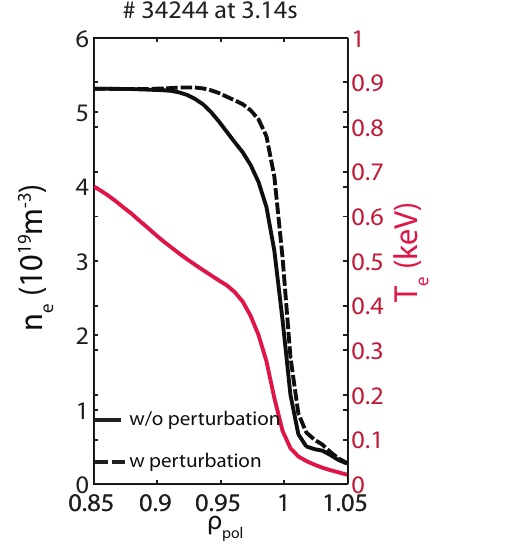
Figure 3. #34244 at 3.14 s: Input profiles of T e (red) and n e (black) used to model the response of the ECE-I and ECE chan- nels to the presence of the density modulation. Background den- sity profile is shown as a black solid line while the perturbed density profile is displayed as black dashed line. The tempera- ture profile is kept the same for the two cases.